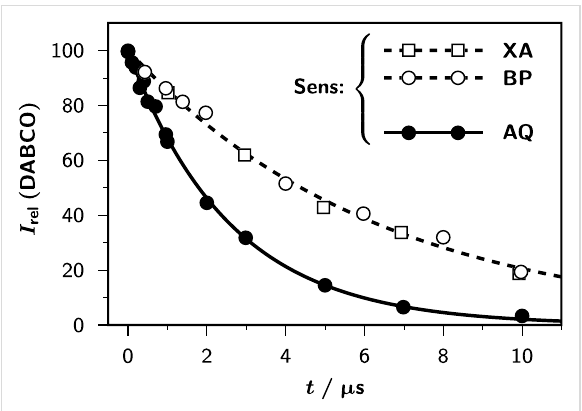
Figure 1: Time-resolved CIDNP in sensitized (sensitizers xanthone (XA), benzophenone (BP), or anthraquinone (AQ)) photoreactions of 1,4-diazabicyclo[2.2.2]octane (DABCO). Shown are the relative CIDNP intensities (integrals) I rel (DABCO) of the 12 equivalent amine protons (s, 2.64 ppm) as functions of the delay t between the laser flash (80…90 mJ) and the sampling NMR pulse (duration, 1 . 0 µs). Tempera- ture, 298 K; amine concentration c 0 , 2 . 77 × 10 − 3 M; sensitizer concen- trations, 1 × 10 − 3 M (AQ, XA) and 6 × 10 − 3 M (BP). The fit functions are first-order rate laws, 100exp [ − k ex c 0 t ]; they also include data points at longer times, which are not shown in the graph. Best-fit exchange- rate constants k ex , 5 . 7 × 10 7 M − 1 s − 1 (XA, BP) and 1 . 39 × 10 8 M − 1 s − 1 (AQ). For further explanation, see text.